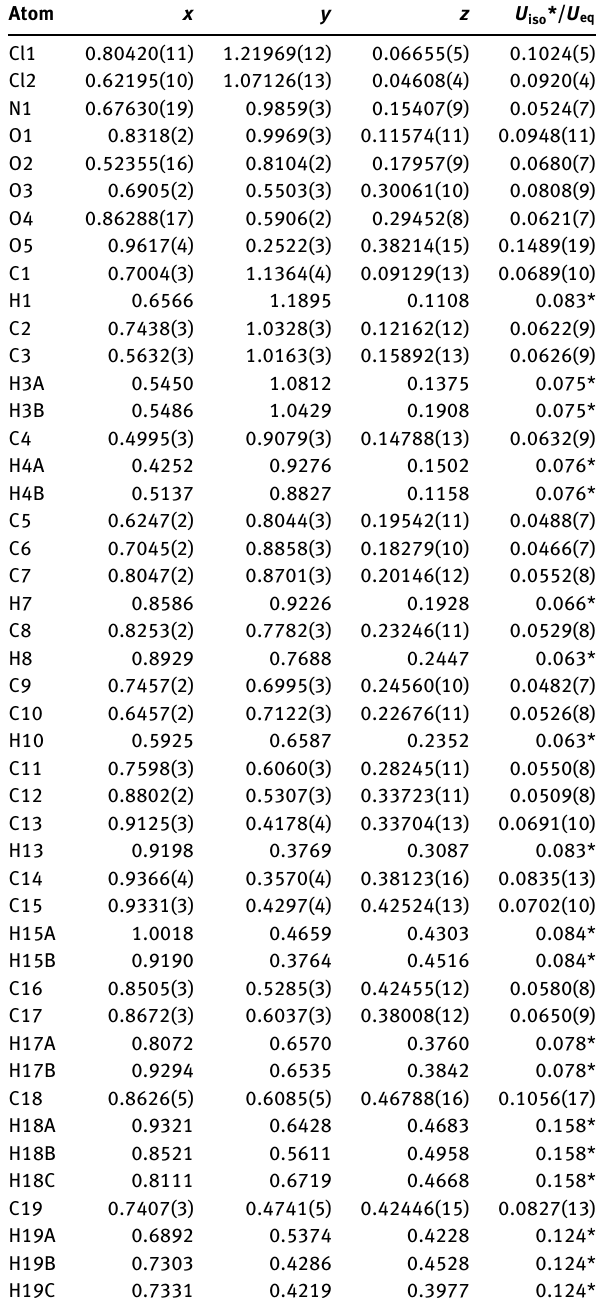
Table 2: Fractional atomic coordinates and isotropic or equivalent isotropic displacement parameters (Å 2